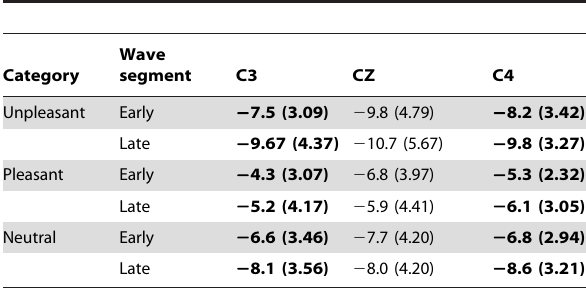
Table 1. Mean and standard deviation values of readiness potential